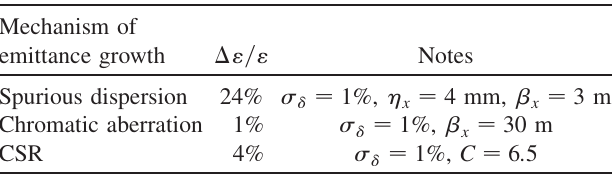
TABLE II. Mechanisms of emittance growth and their theo- retical strength.